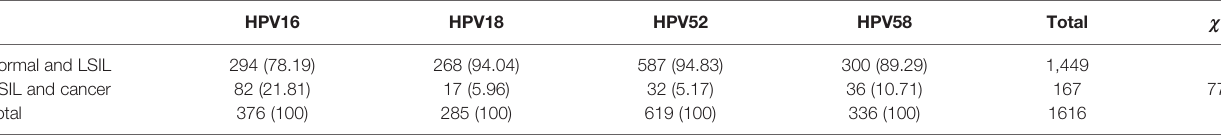
Comparison of HSIL and cervical cancer in each group. *p <0.001.